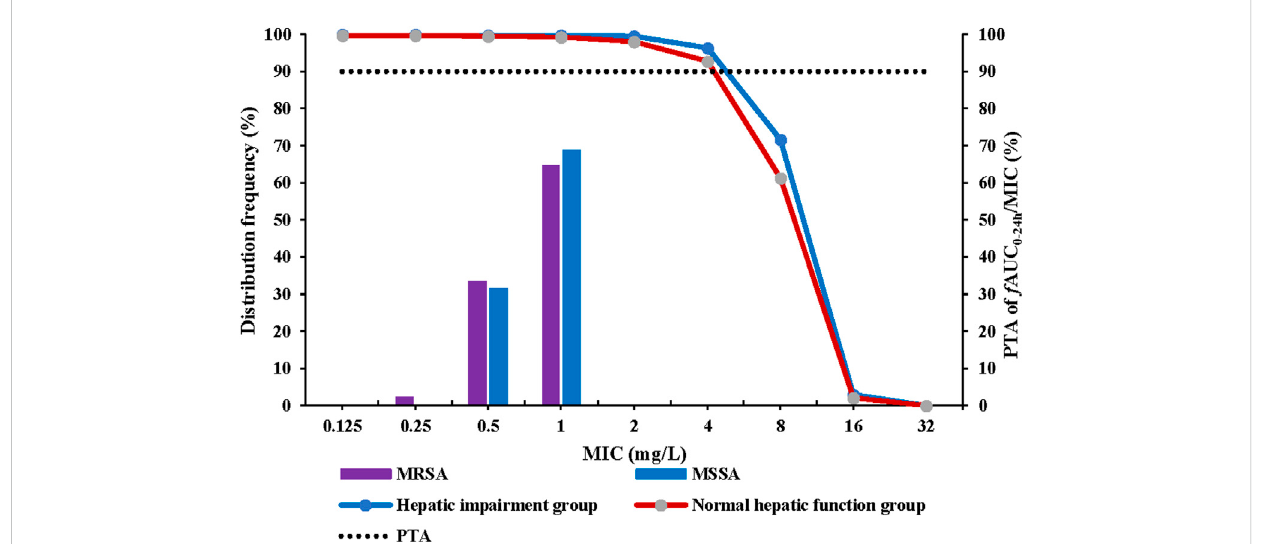
FIGURE 3 PTA at fAUC 0 – 24h /MIC target of 2.3 following oral administration of contezolid 800 mg q12h in the patients with moderate hepatic impairment and healthy controls with normal liver function. MIC, minimum inhibitory concentration; MSSA, methicillin-susceptible S. aureus ; MRSA, methicillin-resistant S. aureus ; q12h, every 12 h; PTA, probability of target attainment.